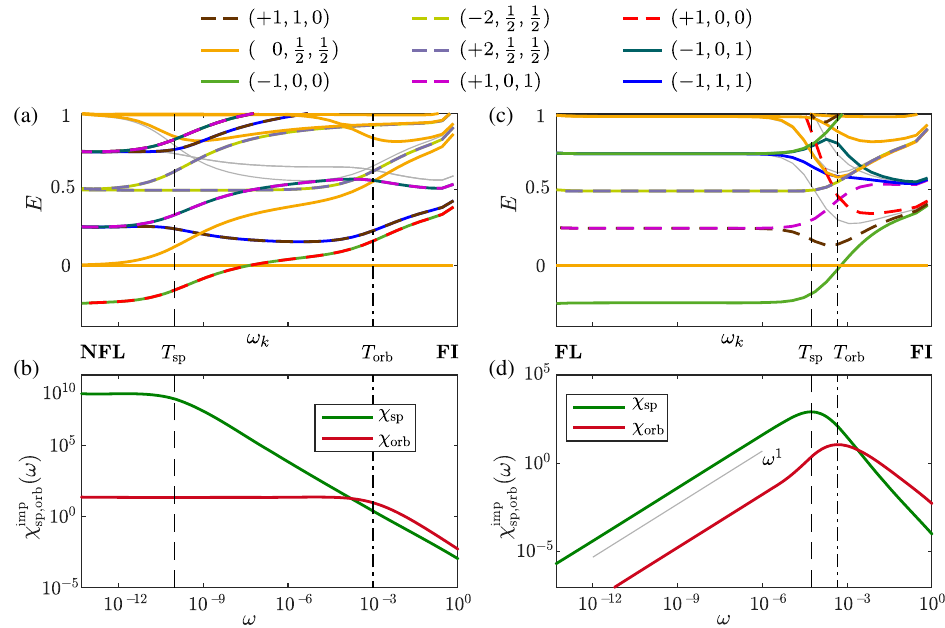
FIG. 8. NRG results for Ye ’ s 2soK model, computed (a),(b) for ð J 0 ; K 0 ; I 0 Þ ¼ ð 0 . 1 ; 0 . 3 ; 0 Þ , respecting particle-hole symmetry, and (c), (d) for (0,0.3,0.05), breaking particle-hole symmetry. (a),(c) Eigenlevel flow diagrams, with quantum numbers ð q; S; λ Þ shown at the top. The low-energy fixed points in (a) and (c) exhibit a NFL or FL spectrum, respectively, reproduced analytically in Table V or VI, respectively. (b),(d) Imaginary part of the impurity ’ s spin and orbital susceptibilities. Vertical lines indicate the crossover scales for orbital screening T (dash-dotted) and spin screening T (dashed), marking when χ imp and χ imp sp (b) bend over to constant behavior or orb sp orb 2000 , D ¼ 1 (d) reach their maxima, respectively. (NRG parameters: Λ ¼ 2 . 5 , N keep ¼